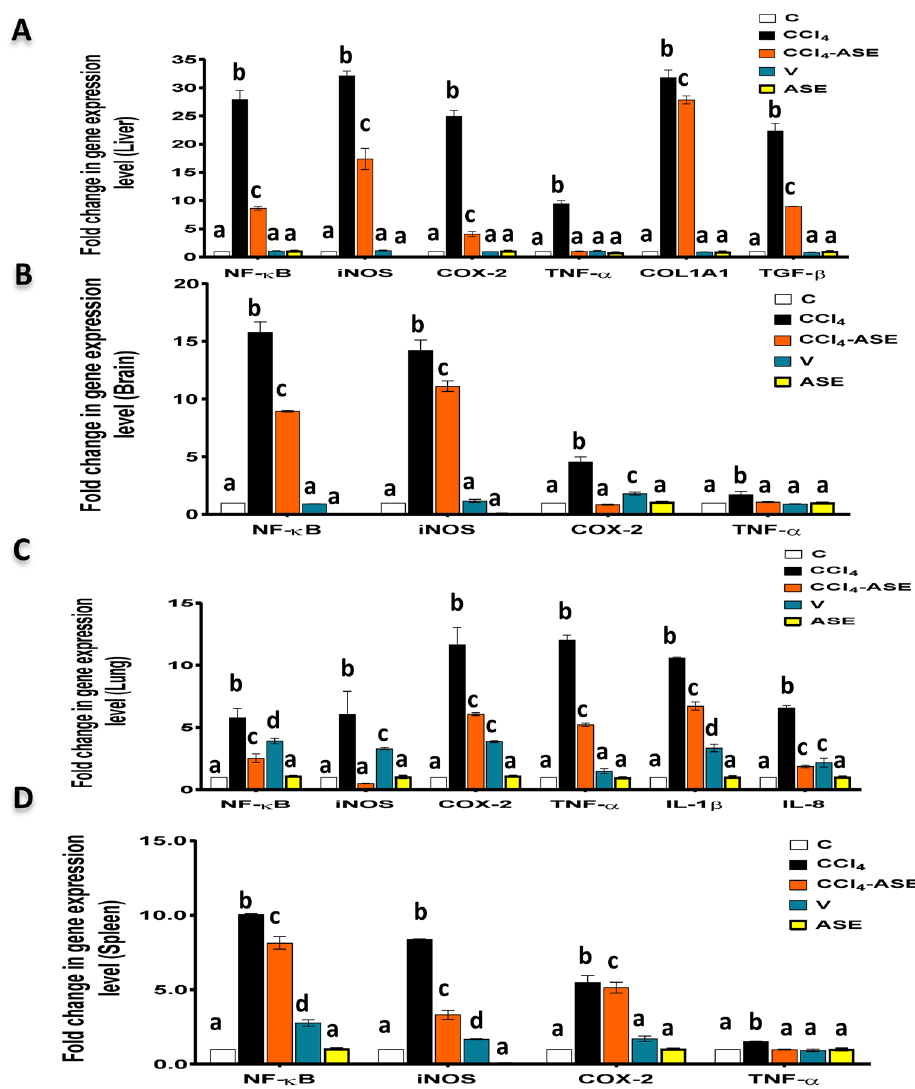
mean ± S.E of 7 animals. C control untreated rats, V olive oil (vehicle of CCl 4 )-administered rats (0.5 ml/kg b.w., ip, 6 times), CCl 4 rats with systemic toxicity induced by CCl 4 injection (1 mL/kg b.w., ip, 6 times), CCl 4 -ASE rats with systemic toxicity after their oral treatment with ASE (7.5 g/kg b.w.) for 10 days. ASE normal rats were administered only ASE (7.5 g/kg b.w.) for 10 days. Different letters refer to the significance at P < 0.05; CCl 4 -ASE group was compared with the